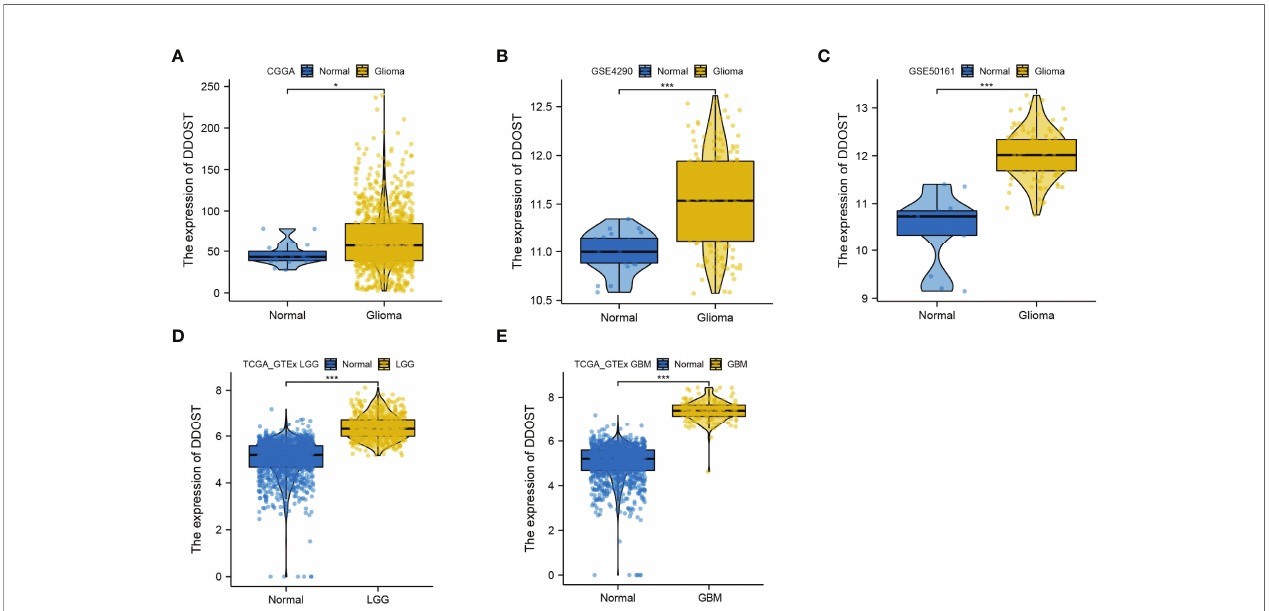
FIGURE 2 | Expression difference of DDOST between glioma and normal tissue. (A) The expression of DDOST was different between glioma and normal brain tissue in the CGGA cohort. (B, C) In the GSE4290 and GSE50161 cohort, DDOST expression was signi fi cantly higher in glioma patients than in normal brain. (D, E) In the TCGA and GTEx, the expression of DDOST in LGG and GBM was signi fi cantly higher than that in normal tissue. * p < 0.05, *** p < 0.001.